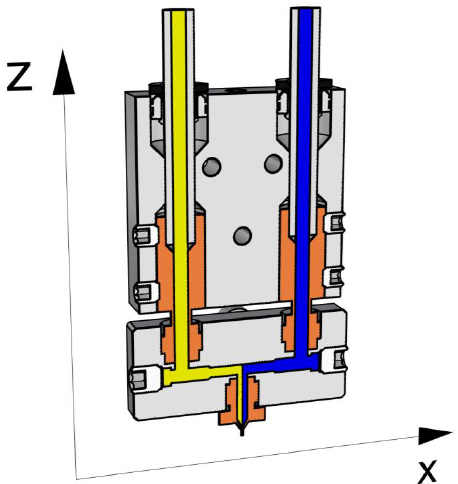
Figure 1. Cyclops hotend representation. In the lower portion (heating block), it is possible to see that both materials converge in the same nozzle (CAD model adapted from GrabCAD [23]). According to the computer numerical control programming language (G-code), the required fractions of each material were obtained by simultaneously controlling the amount of material pushed by each extruder. Adopting the Marlin firmware, the material percentage was coded into the G-code by the commands, M163 and M164. The former one set the mutual amount of each mate- rial, whereas the second latter one assigned the mixing to a virtual extruder [24], such as: M163 S0 P0.75 M163 S1 P0.25 M164 S3 which means that the tool number 3 was set to be 75% of the material in the left chan- nel and 25% of the material in the right channel. To obtain the needed tool, it was neces- sary introducing the line T n in the right position of the G-code listing, where n is the num- ber of the tool (3 in the example, i.e., T3) [25]. To use the commands M163 and M164, the Marlin configuration file (Configuration h) must be modified, thereby enabling the mixing extruder [26]. 2.2. Materials and Process Parameters The PLA-TPU and ASA-TPU pairs of materials were studied. The choice of these pairs allows us to obtain a wide range of properties, while maintaining rather similar pro- cess parameters. In detail, the materials used in this research are PLA Extrafill, ASA Ex- trafill, and Flexfill TPU 98A (hardness 98 Shore A), which are 3 thermoplastic filaments produced by Fillamentum [27] (Table 1). All of the filaments were supplied in spools in a standard 1.75 mm diameter. PLA is the most widely used thermoplastic filament for FDM. PLA is a rigid and brittle filament that is easy to use, and it is biodegradable in industrial composting sys- tems. While ASA has similar properties to ABS, it is more eco-friendly and has better UV resistance. TPU is a semi-flexible material that offers high tensile strength and high elon- gation at break values.